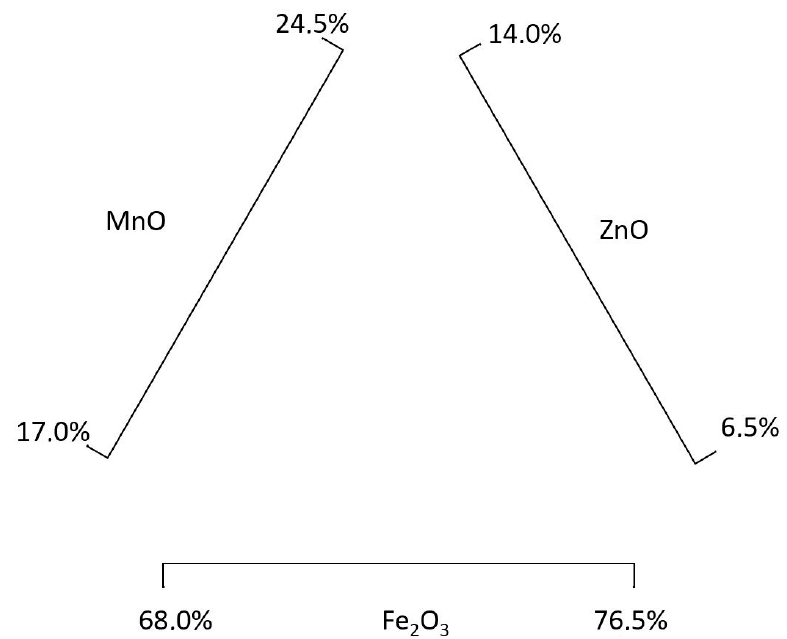
Figure 2. MnZn soft ferrite composition diagram.